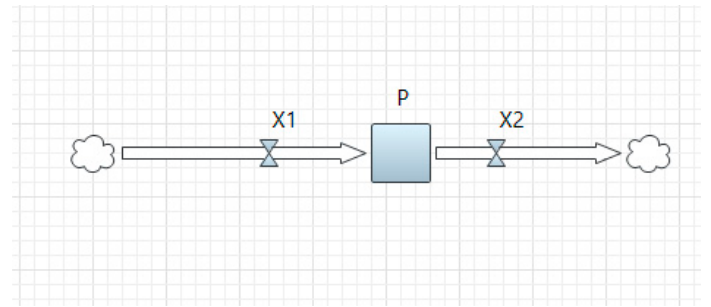
Figure 10. Creating the flows and the drive. Source: designed by authors.